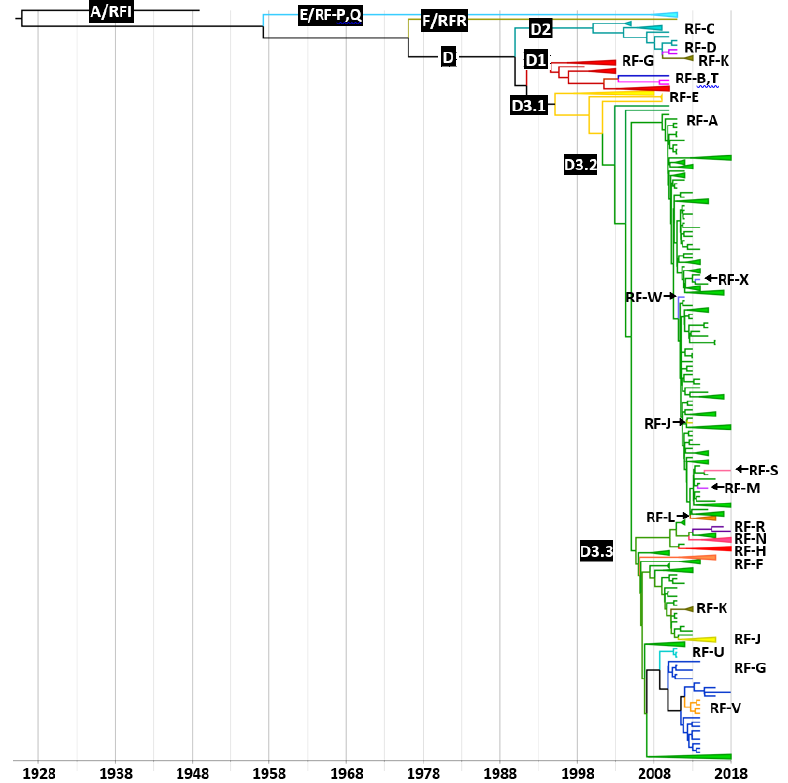
Figure 4. Phylogeny inferred from the P1 genomic region of coxsackievirus A6. A set of 760 P1 sequences was constructed from the 213 complete genomes from this study and 547 genomes available in GenBank. The phylogenetic analysis was performed with BEAST software [30]. Posterior probability is indicated by the size and intensity of the red colour of the circles at the different nodes. The inset table indicate the time to the most recent common ancestor (tMRCA) and the 95% highest probability density interval (95%